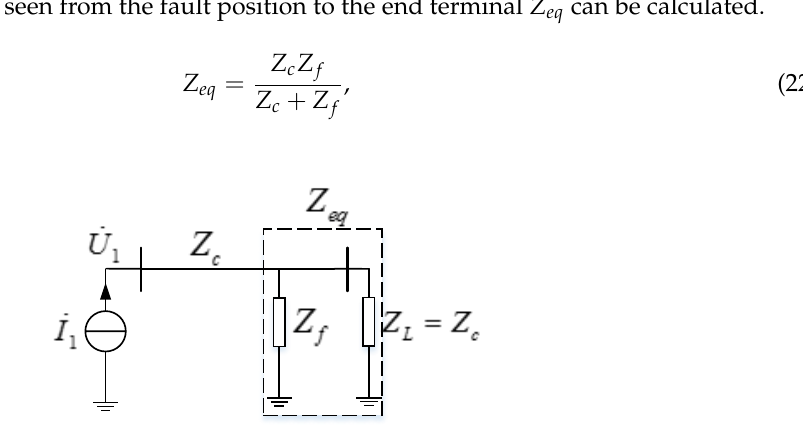
Figure 7. Non-metallic short circuit with matching terminal resistor.